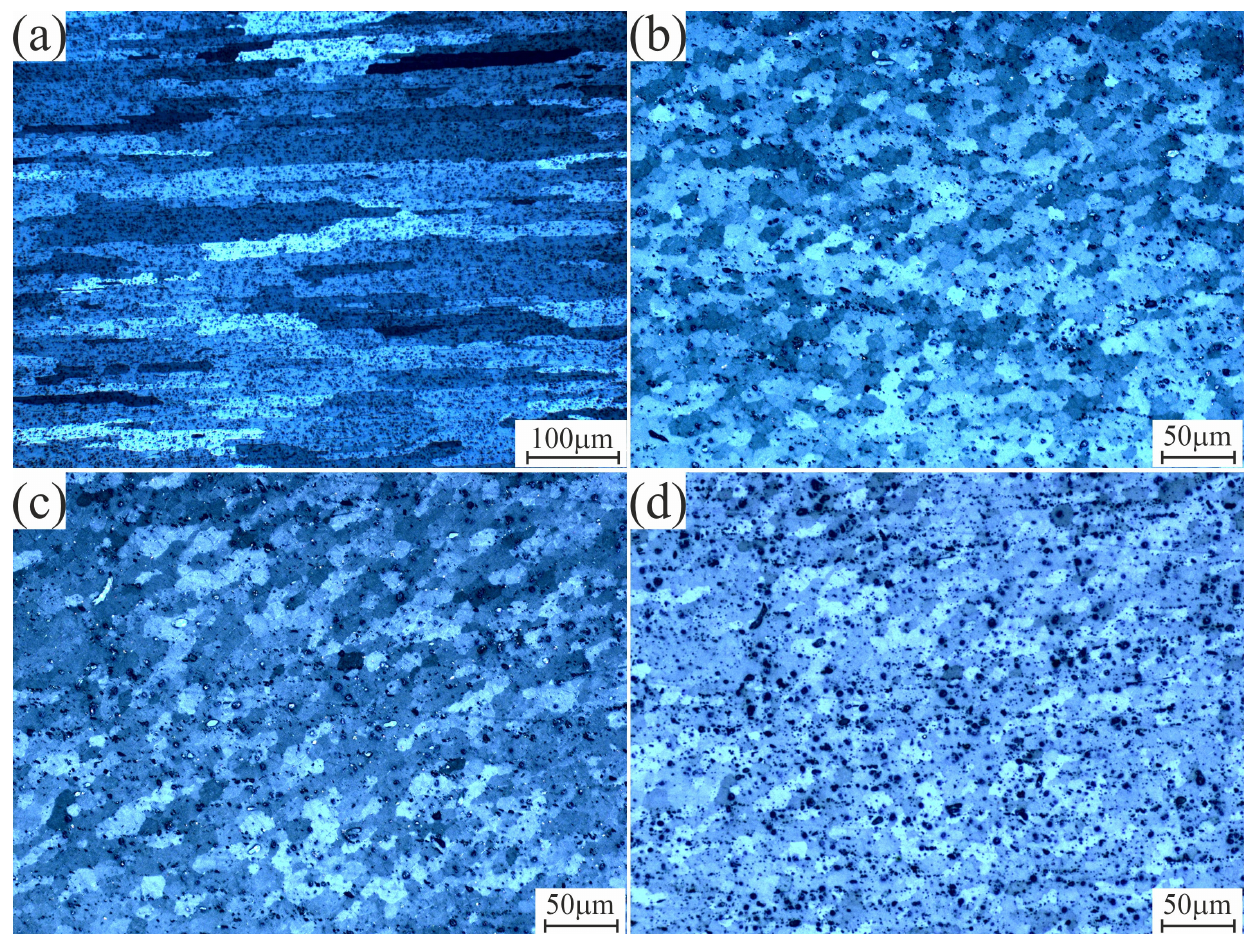
Figure 3. The microstructure of the as ‐ received AA6061 alloy sheets and the manufactured compo ‐ sites; ( a ) as ‐ received alloy sheets, ( b ) AA6061/NbC, ( c ) AA6061/VC, and ( d ) AA6061/NbC + VC.